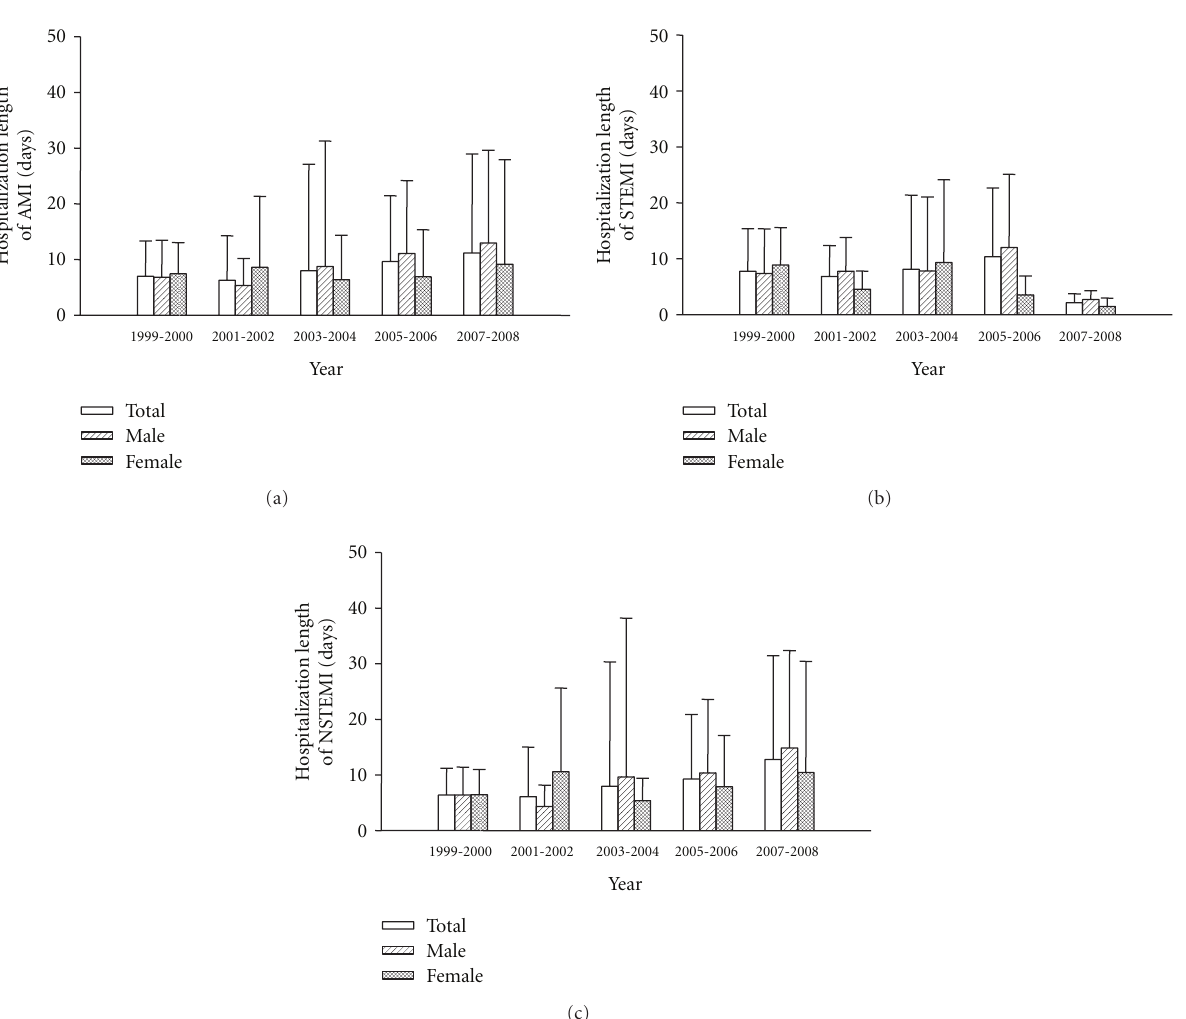
Figure 4: Hospitalization lengths of total, male, and female acute myocardial infarction (AMI, (a)), ST elevation MI (STEMI, (b)), or non-ST elevation MI (NSTEMI, (c)) from 1999 to